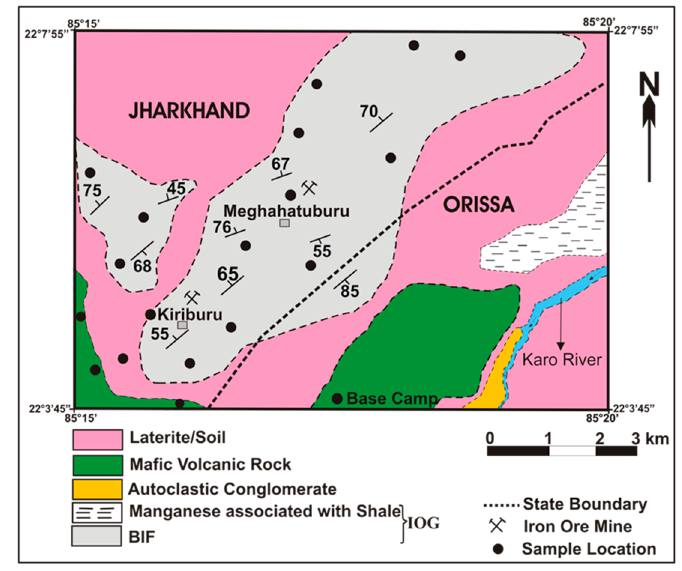
Figure 3. Deposit scale geological map of Kiriburu-Meghahatuburu mining area.